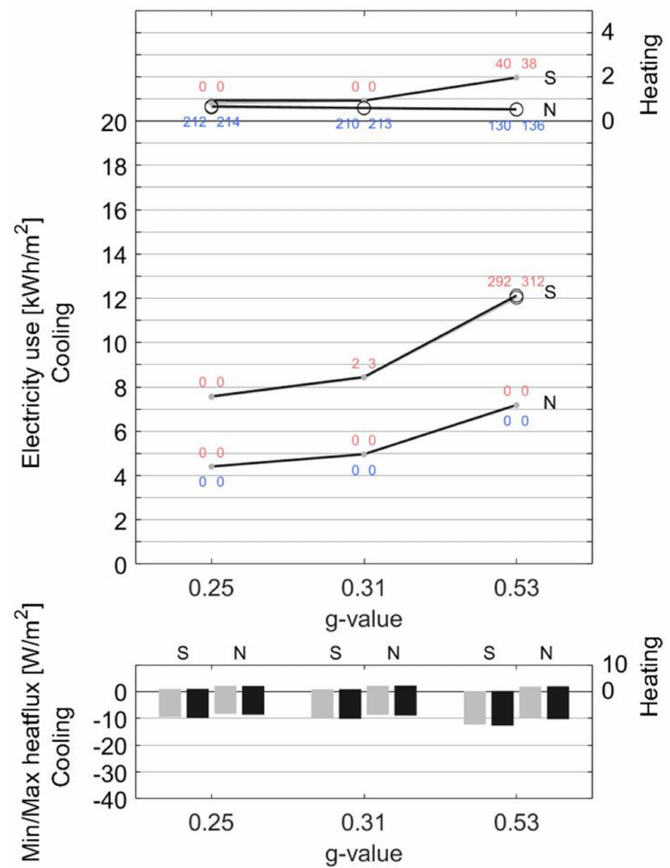
Figure 7. Core diagram of the feasibility guide showing parameter relations. Upper part: cooling (left axis) and heating usage (right axis) depending on the glazing g-value. Solid lines for North (N) and South-oriented (S) windows as well as two mass flow rates, which are coinciding here. Red and blue numbers indicate cumulative hours above and below thermal comfort thresholds (26 ◦ C and 21 ◦